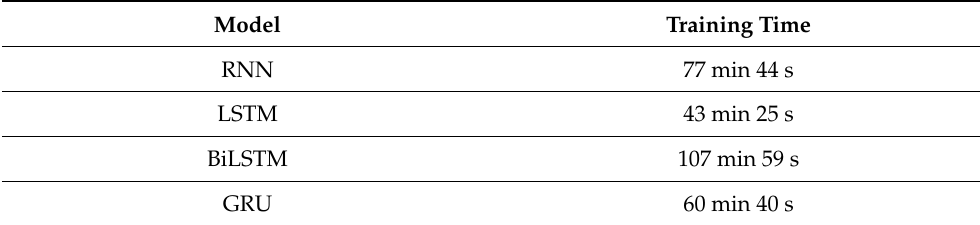
Table 4. Computational cost of different DL and hybrid DL